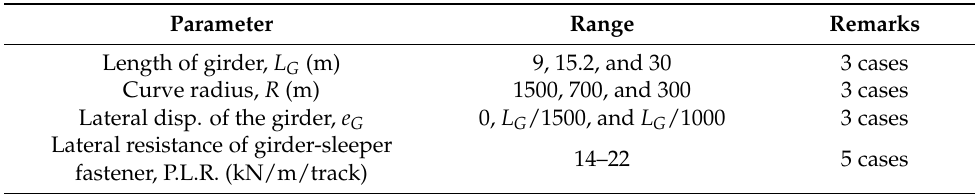
Table 5. Analysis Table 5. Analysis parameters.